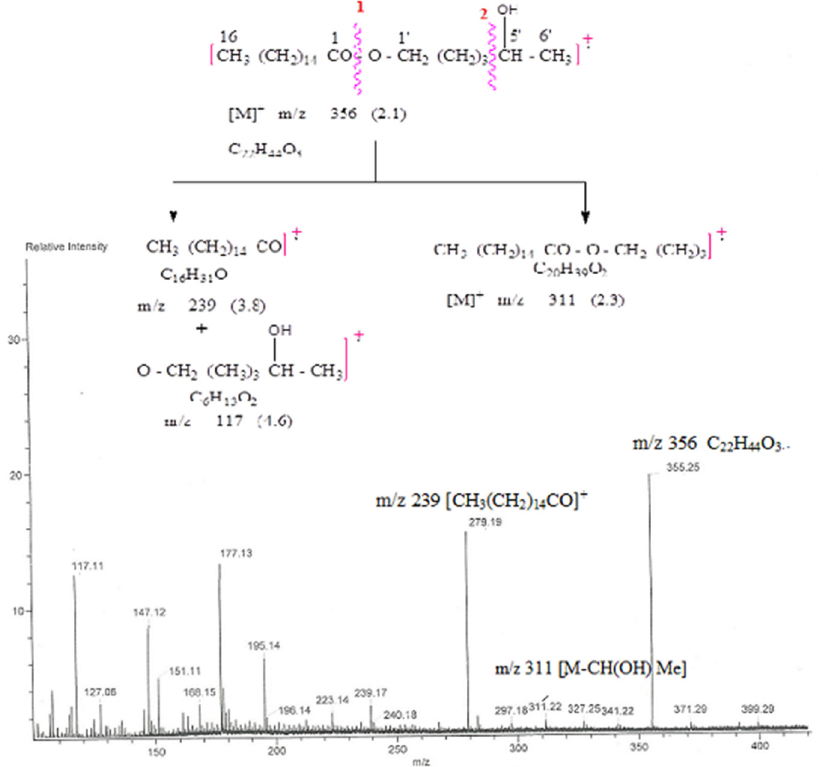
Scheme. 3. Isolated compound n-deconoyl- β -D-glucopyranoryl-(2 ′→ 1 ′′ )- β -D-glucopyranoside (AB 03).